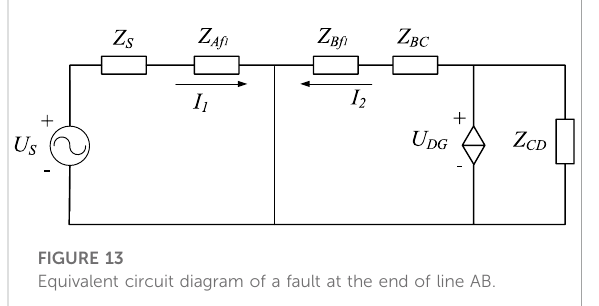
FIGURE 13 Equivalent circuit diagram of a fault at the end of line AB.